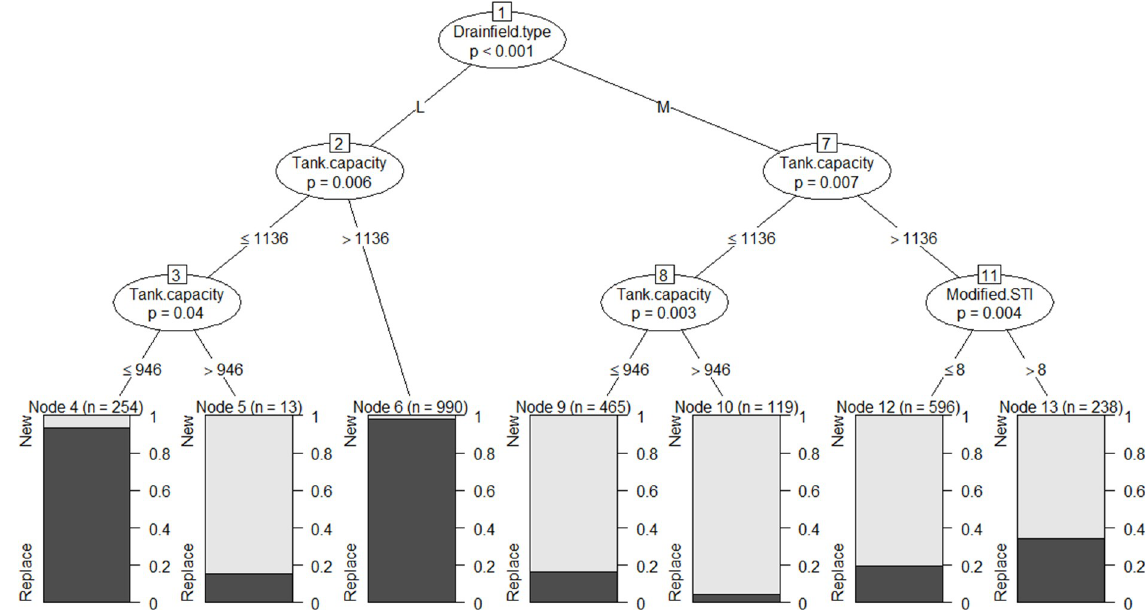
Fig 7. Classification inference tree model based on the training data set (n = 2675). Values and letters ( M = Mounded and L = Level) on lines connecting input variables indicate splitting criteria (e.g., if it is noted M all septic systems with Mounded drainfield were placed in the group to the right on the branch, otherwise there were placed on the branch to the left). Numbers in boxes attached to input variables show the node number. “n” above the terminal nodes indicates the number of septic systems classified in that node. “ p” represents the p -value for splitting the nodes (here p -value < 0.05). Tank capacity was calculated as litter per bedroom. Bar charts illustrate the proportion of septic systems Replace (black) or New (light gray) in that